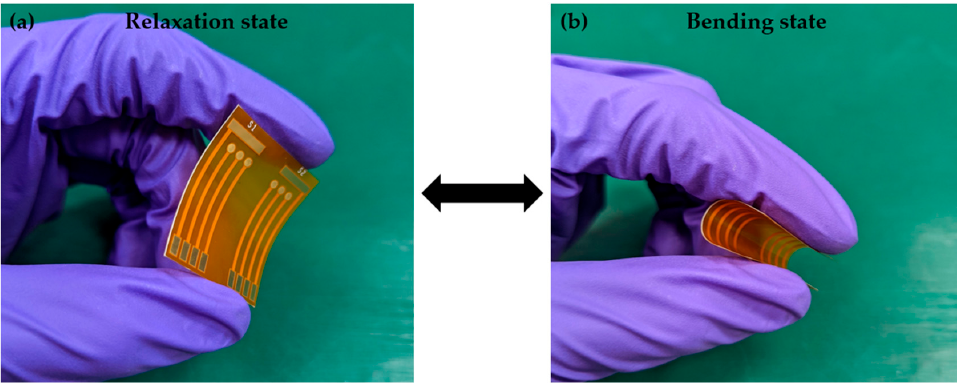
Figure 9. Photograph of a fatigue test of the pH sensor based on FPCB.